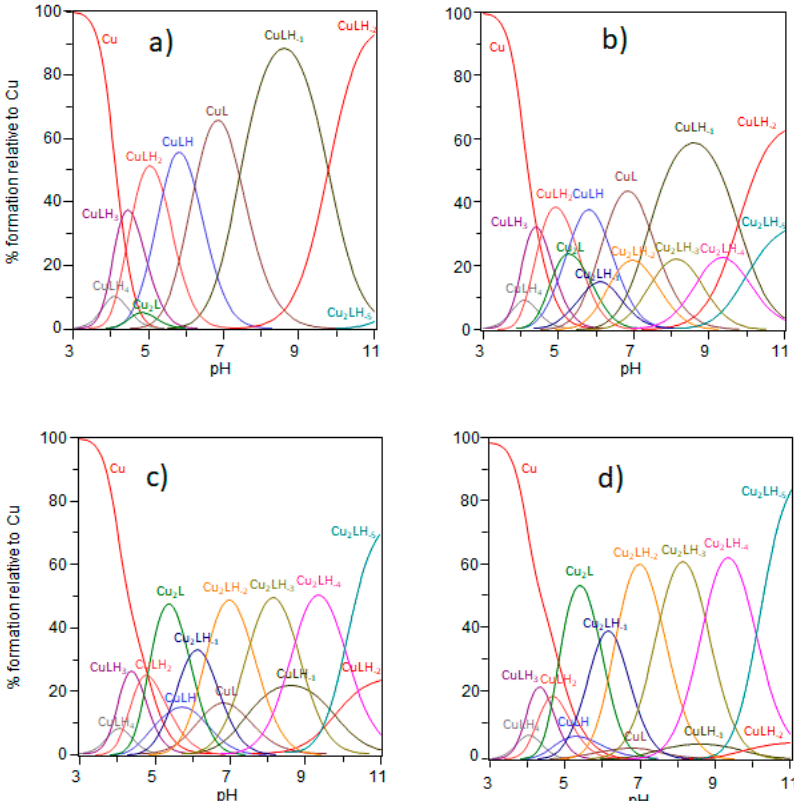
Figure 1. Species distribution for the Cu 2+ - Ctr1 (1-14) system. C Ctr1 = 5 × 10 − 4 mol dm − 3 ; Cu 2+ /Ctr1 (1-14) concentration ratio is 0.9, 1.2, 1.6 and 1.9 for ( a – d ), respectively.